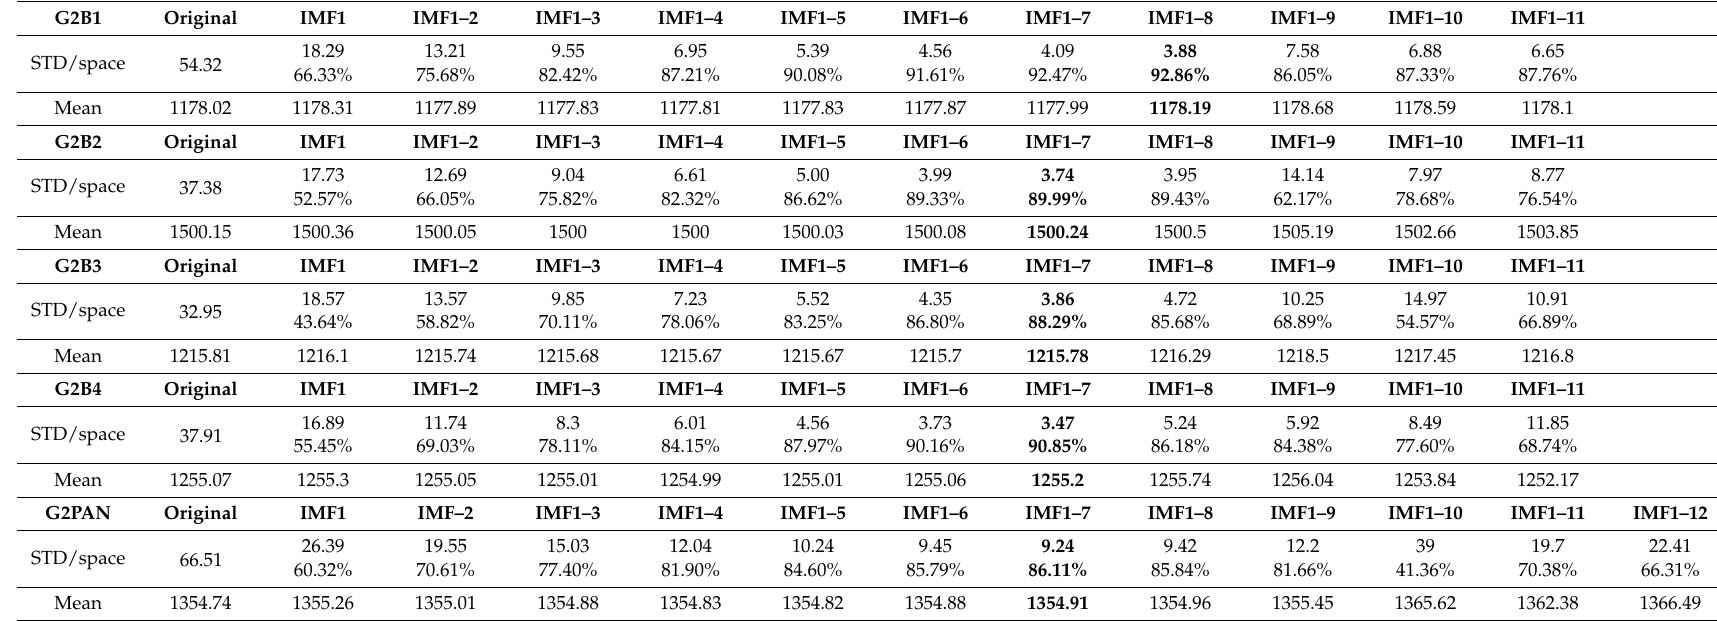
Table 4. Same as Table 3, but for gain setting